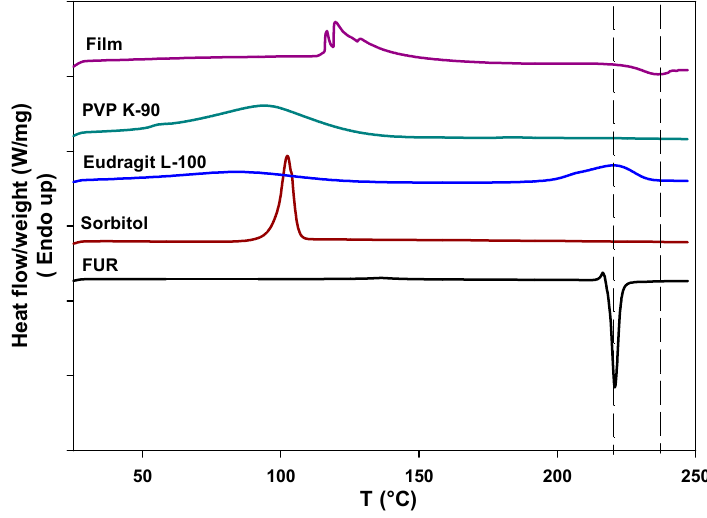
Figure 1. Differential Scanning Calorimetry (DSC) thermograms of the Furosemide (FUR)-loaded film and of all the individual components present in the film.